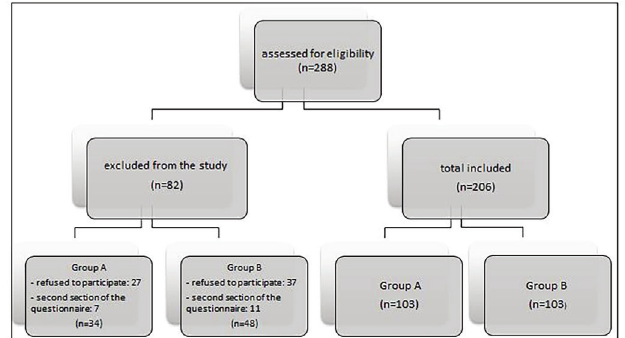
Figure 1 -Diagram of participant progress through study